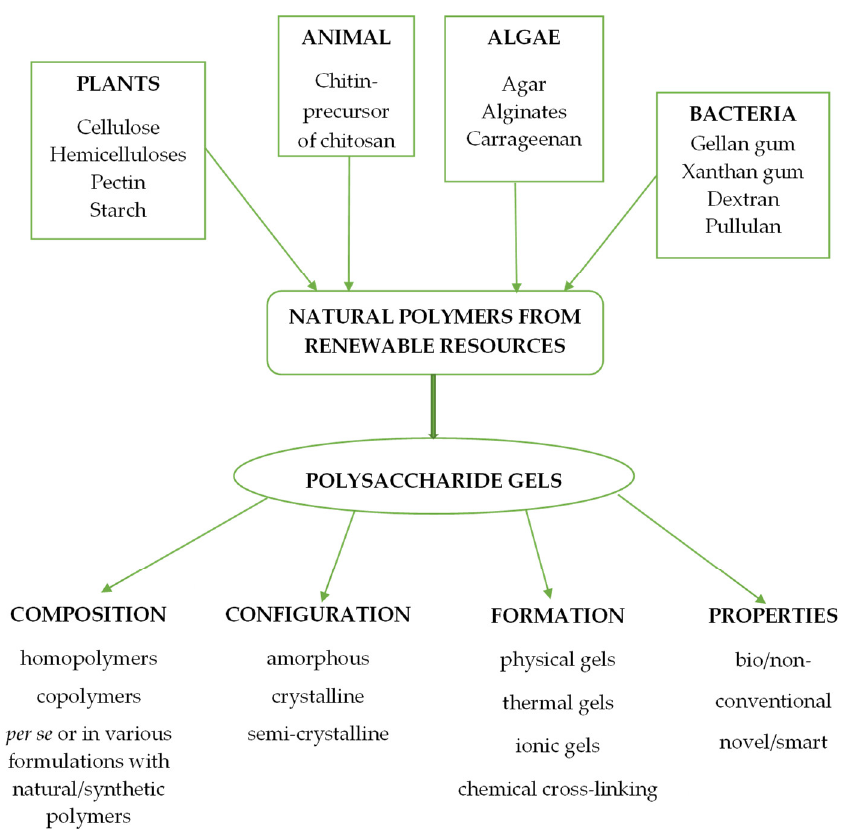
Scheme 1. Polysaccharide gels: sources, types, and general